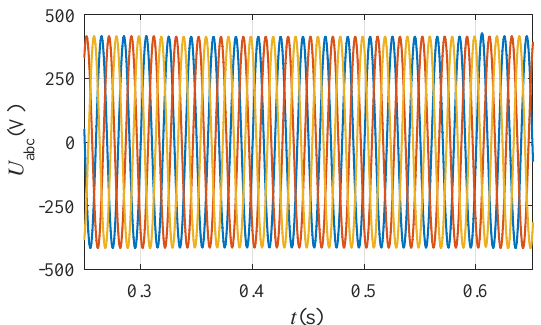
Figure 10. Variation of voltage under ACB control strategy.